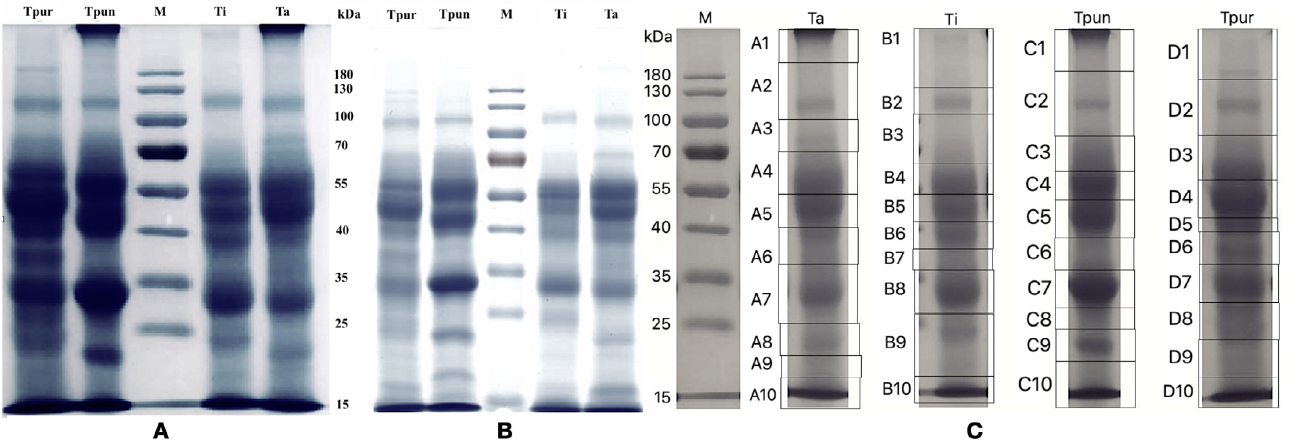
Figure 3. One-dimension electrophoretic profile of (A) 60 µg and (B) 30 µg of venom of T. albolabris (Ta), T. insularis (Ti), T. puniceus (Tpun), T. purpureomaculatus (Tpur). M represents the molecular weight standard in kDa. (C) Gel with 60 µg of crude venom was divided into sections (1-10) and further used for in-gel digestion and ESI-LCMS/MS. Ta, Ti, Tpun, Tpur showed gel sections for T. albolabris , T. insularis, T. puniceus and T. purpureomaculatus ,